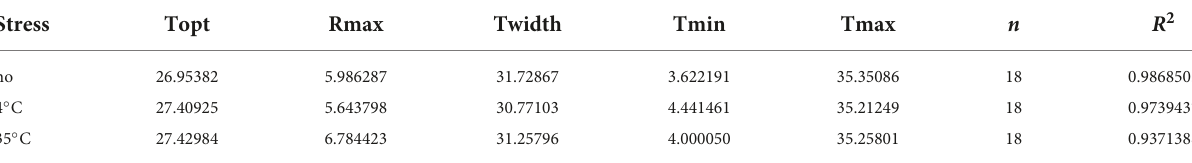
TABLE 1 Parameter estimates of the thermal reaction norm when Sphaeropsis sapine a has been exposed to a previous temperature stress or having not been exposed.